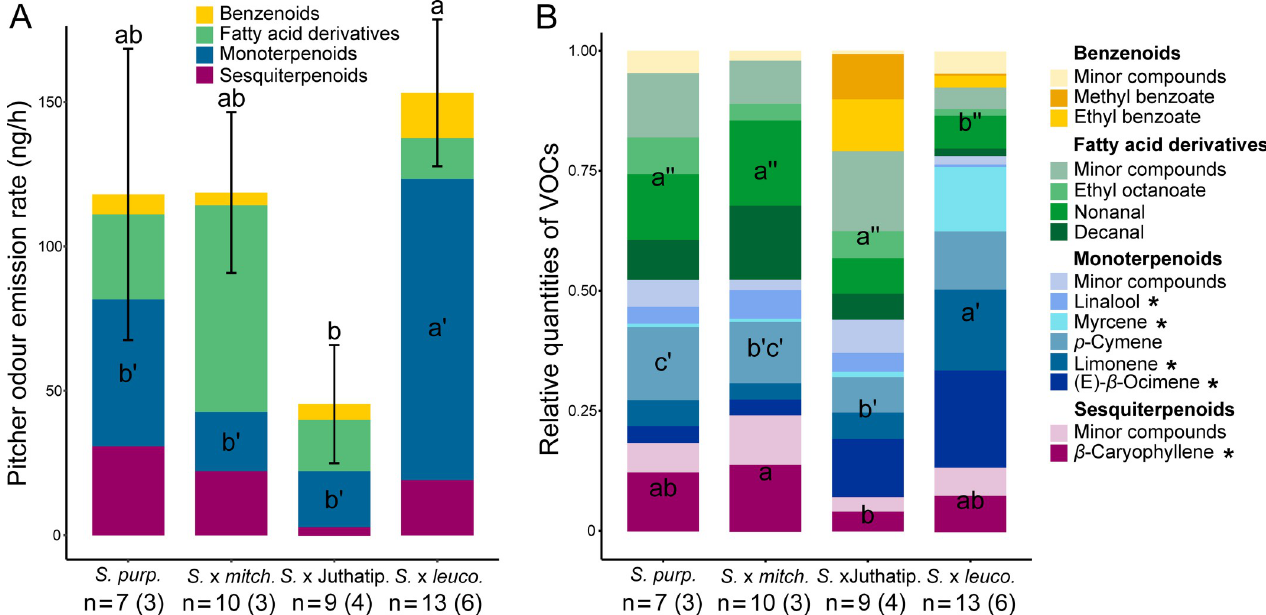
Fig 3. Odour profiles of the Sarracenia taxa. Odour profiles of pitchers of the four taxa in terms of emission rates (A) and VOC relative quantities (B). Mean values are presented with their associated standard errors (A). Only major VOCs representing more than 5% of the quantity of the odour bouquet were detailed (B). “ � ” indicates extremely common compounds in flower scents in Angiosperms (i.e. present in more than half of the seed plant families after Knudsen 2006). Different letters show statistically significant differences (P < 0.05) in means between plant taxa for absolute (A) and relative (B) quantities of each class of VOCs according to the mixed linear models considering also the effects of the random variables “Sampling session” and ‘Plant identity” and using pairwise tests with Holm’s correction for multiple comparisons. The number of sampled pitchers is shown with the number of plants in brackets.